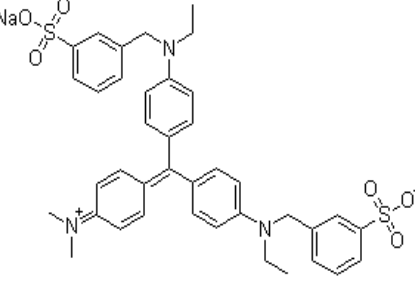
Figure 1 Molecular structure of Acid Violet